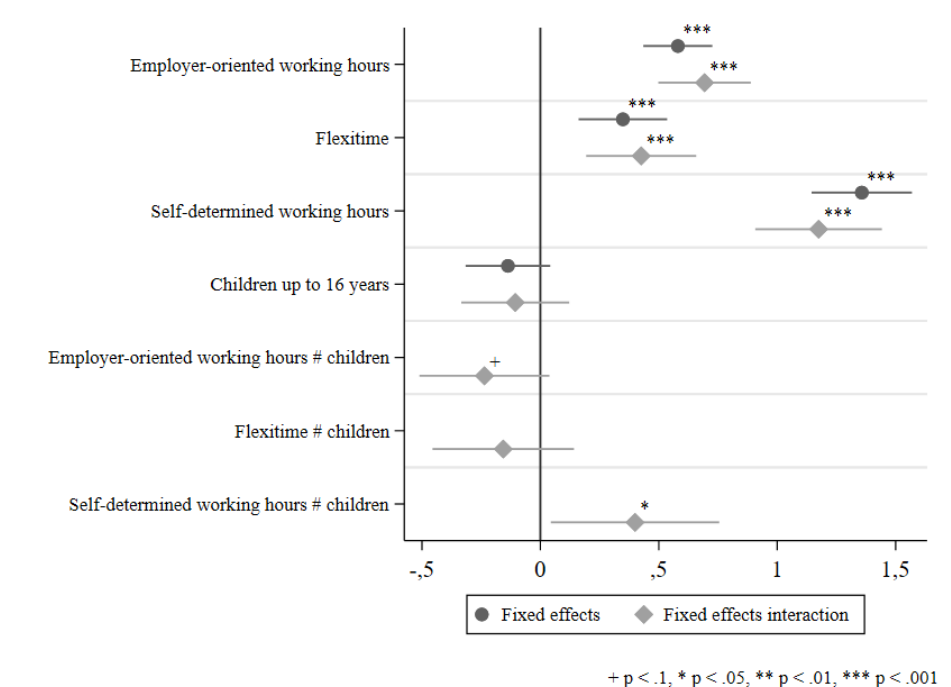
Figure 1 : Fixed effects models for actual working hours for men in general with interaction between working time arrangements and